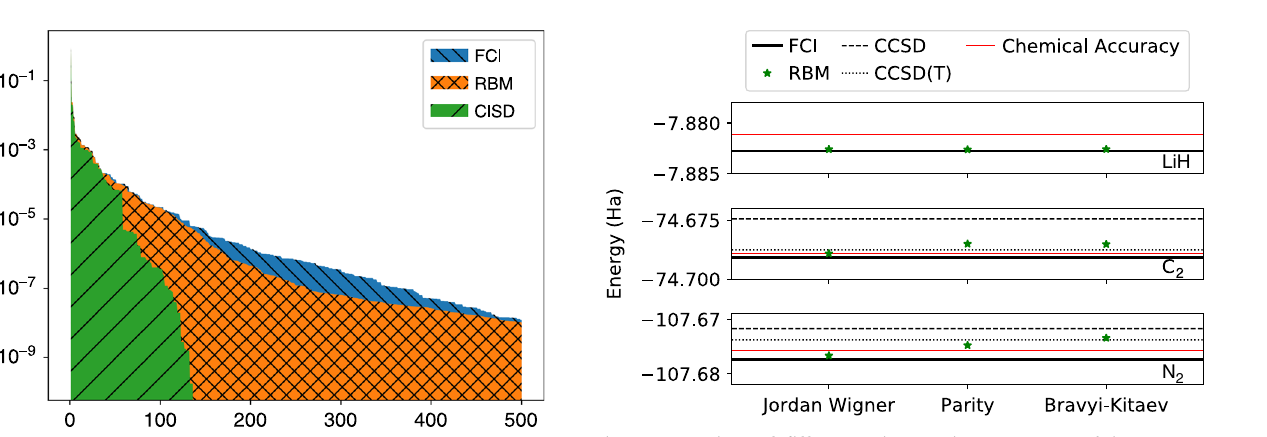
Fig. 3 Comparison of different spin mappings. Accuracy of the RBM (green star) representations for three different mapping types (Jordan – Wigner, Parity, and Bravyi – Kitaev) and three different molecules (LiH, C 2 , and N 2 ) in their equilibrium con fi guration in the STO-3G basis. The geometries used are reported in the Methods section.